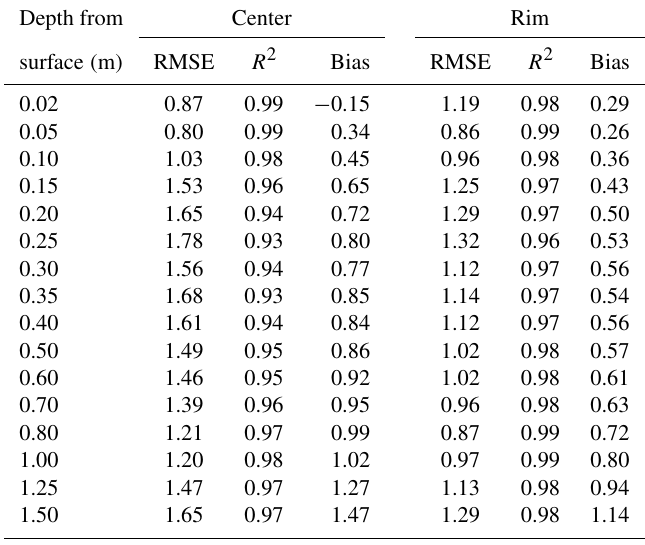
Table E4. Model performance statistics at Site D compared to observed soil temperatures. Depth from Center Rim surface ( m